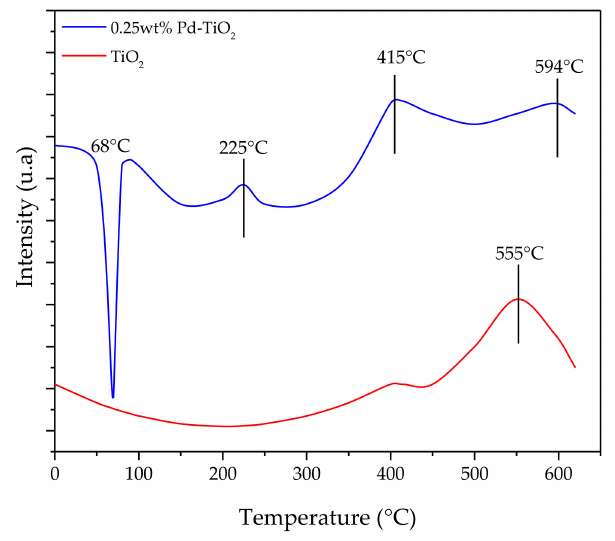
Figure 3. Temperature Programmed Reduction (TPR) of TiO 2 and 0.25 wt% Pd-TiO 2